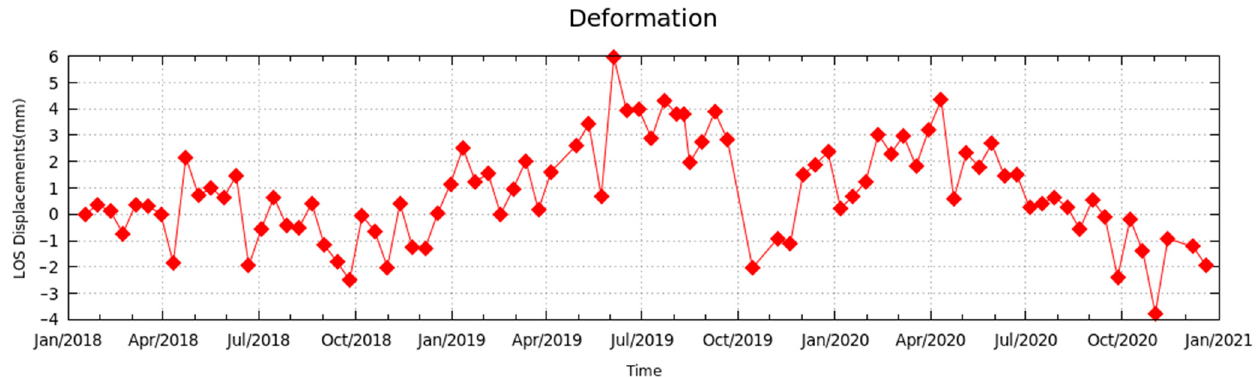
Figure 16. Deformation of point P6 during the monitoring period.